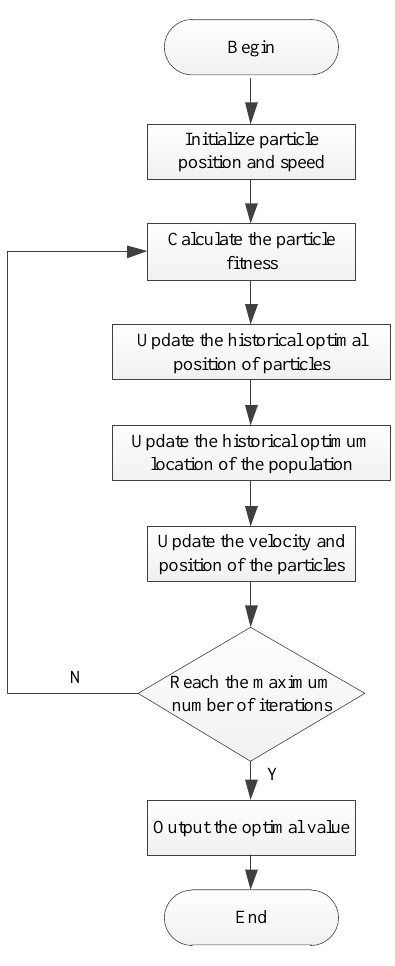
Figure 6. Flowchart describing each step of optimization. From the mutual inductances M 12 and M 34 in Figure 5b, we can assume that M 12 and M 34 satisfy the following relation,